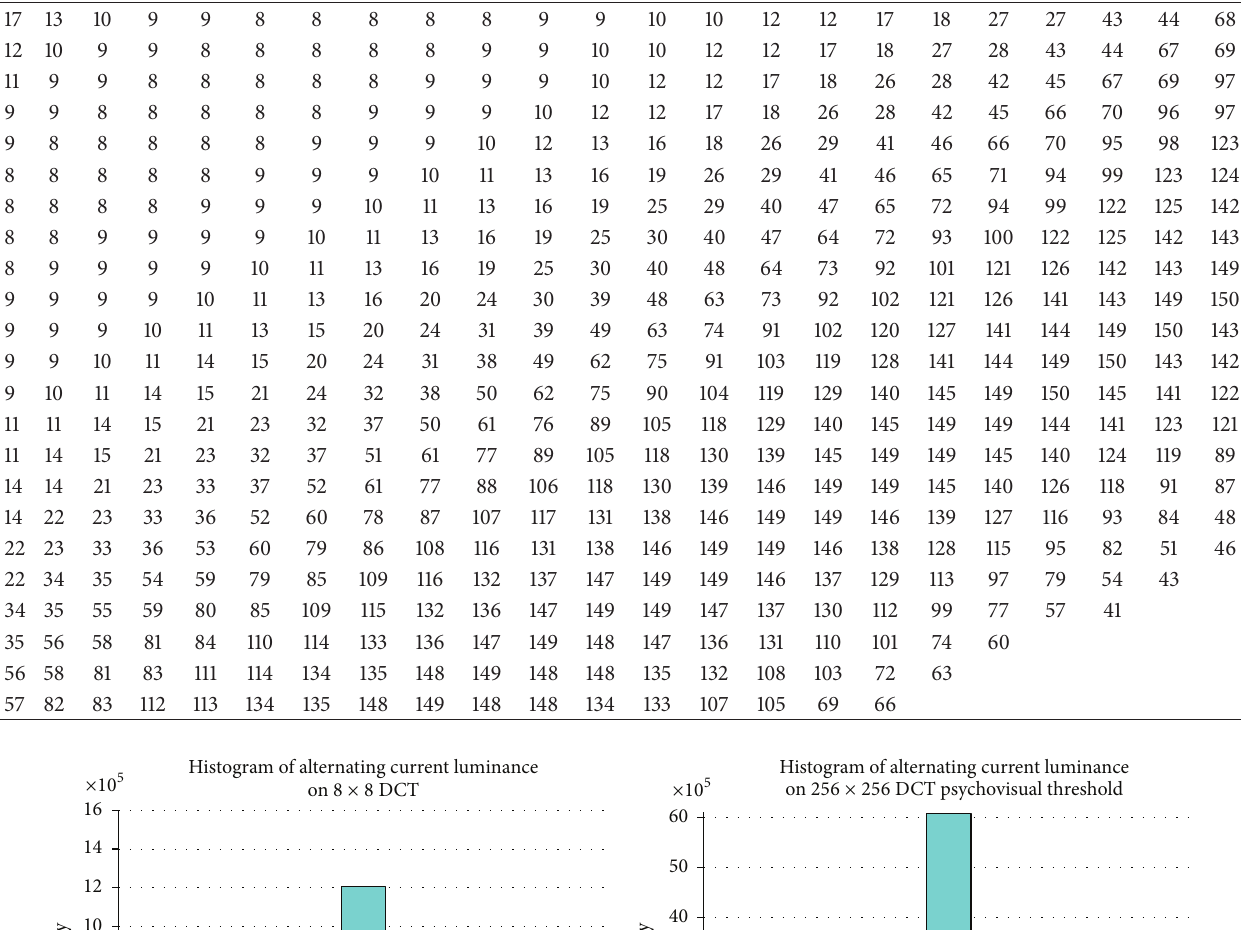
Table 3: The quantization value on each frequency order for chrominance.